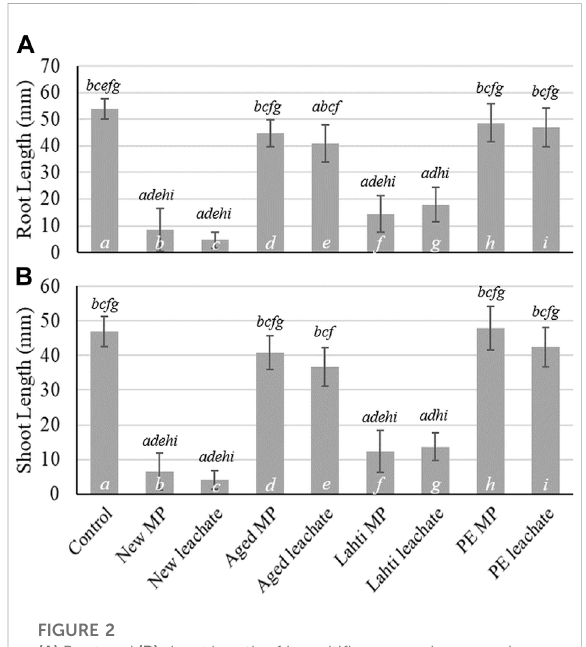
FIGURE 2 (A) Rootand (B) shootlengthof L.multi fl orum seedsexposed to the eight treatments versus an unexposed control. Bar graphs represent mean length (in mm) ± standard deviation ( n = 24). Signi fi cant differences are indicated by the letter above the bars ( p <